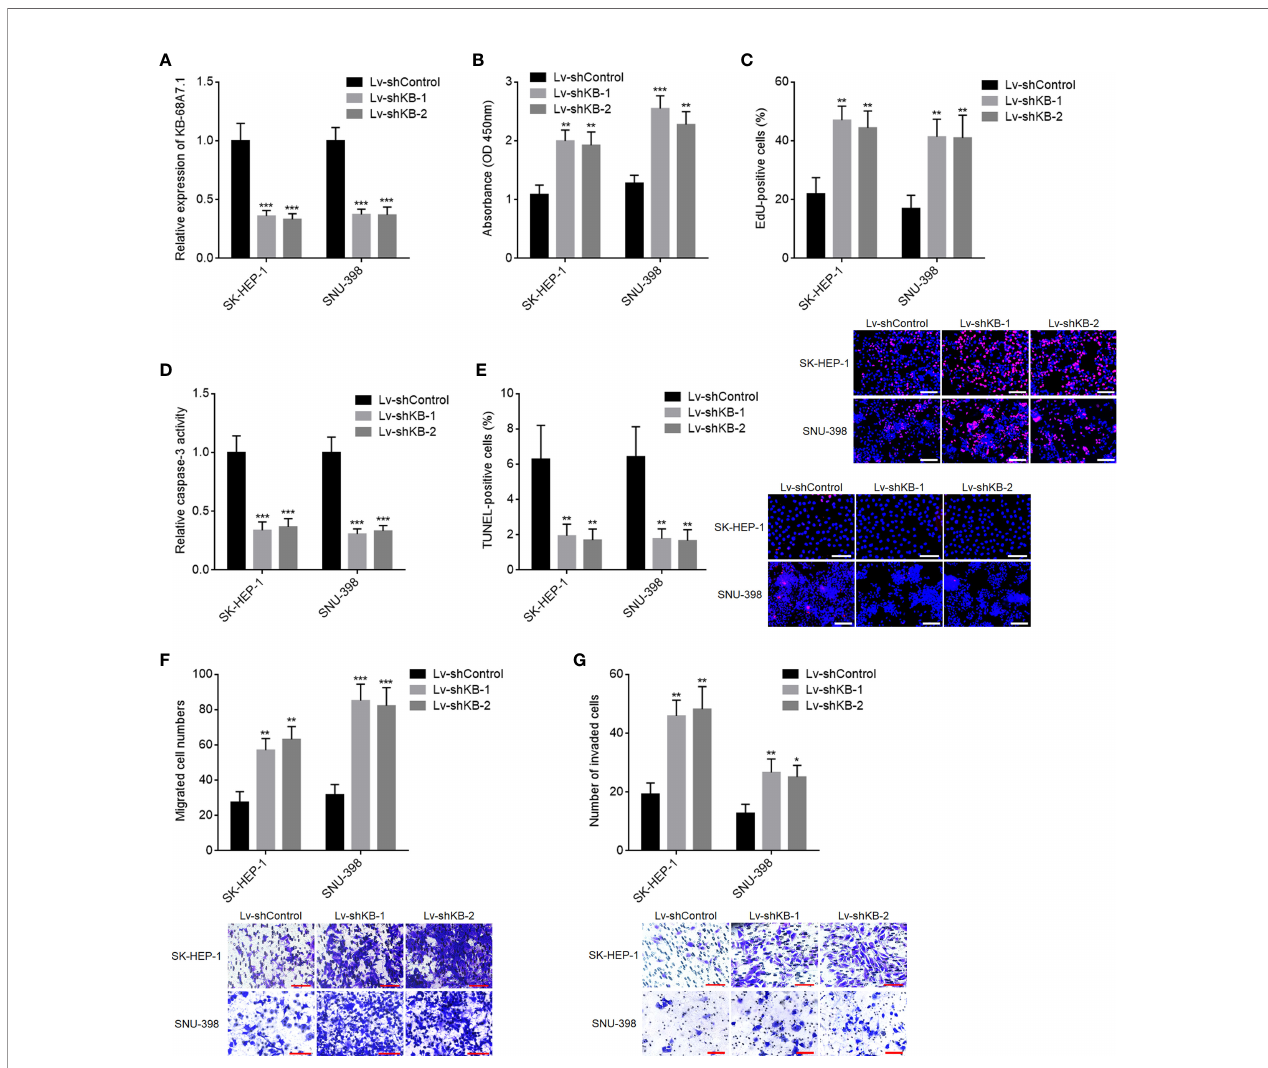
FIGURE 3 | The roles of KB-68A7.1 silencing in HCC cellular proliferation, apoptosis, migration, and invasion. (A) KB-68A7.1 expression in SK-HEP-1 and SNU-398 cells with KB-68A7.1 stable silencing or control was measured by RT-qPCR. (B) Cellular proliferation of SK-HEP-1 and SNU-398 cells with KB-68A7.1 silencing or control was measured by CCK-8 assay. (C) Cellular proliferation of SK-HEP-1 and SNU-398 cells with KB-68A7.1 silencing or control was measured by EdU incorporation assay. Representative images are shown on low right. Red colour indicates EdU-positive and proliferative cells. Scale bars = 100 µm. (D) Cellular apoptosis of SK-HEP-1 and SNU-398 cells with KB-68A7.1 silencing or control was measured by caspase-3 activity assay. (E) Cellular apoptosis of SK-HEP-1 and SNU-398 cells with KB-68A7.1 silencing or control was measured by TUNEL assay. Representative images are shown on the right. Red colour indicates TUNEL- positive and apoptotic cells. Scale bars = 100 µm. (F) Cellular migration of SK-HEP-1 and SNU-398 cells with KB-68A7.1 silencing or control was measured by Transwell migration assay. Representative images are shown below. Scale bars = 100 µm. (G) Cell invasion of SK-HEP-1 and SNU-398 cells with KB-68A7.1 silencing or control was measured by Transwell invasion assay. Representative images are shown below. Scale bars = 100 µm. Results are shown as mean ± SD based on three independent experiments. *p < 0.05, **p < 0.01, ***p < 0.001 by one-way ANOVA followed by Dunnett ’ s multiple comparisons